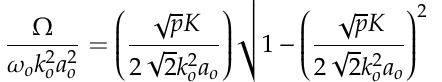
Figure 12. Instability diagram surface for the rotated 1+1 NLS equation as a function of the modulational wavenumber and the rotation angle.